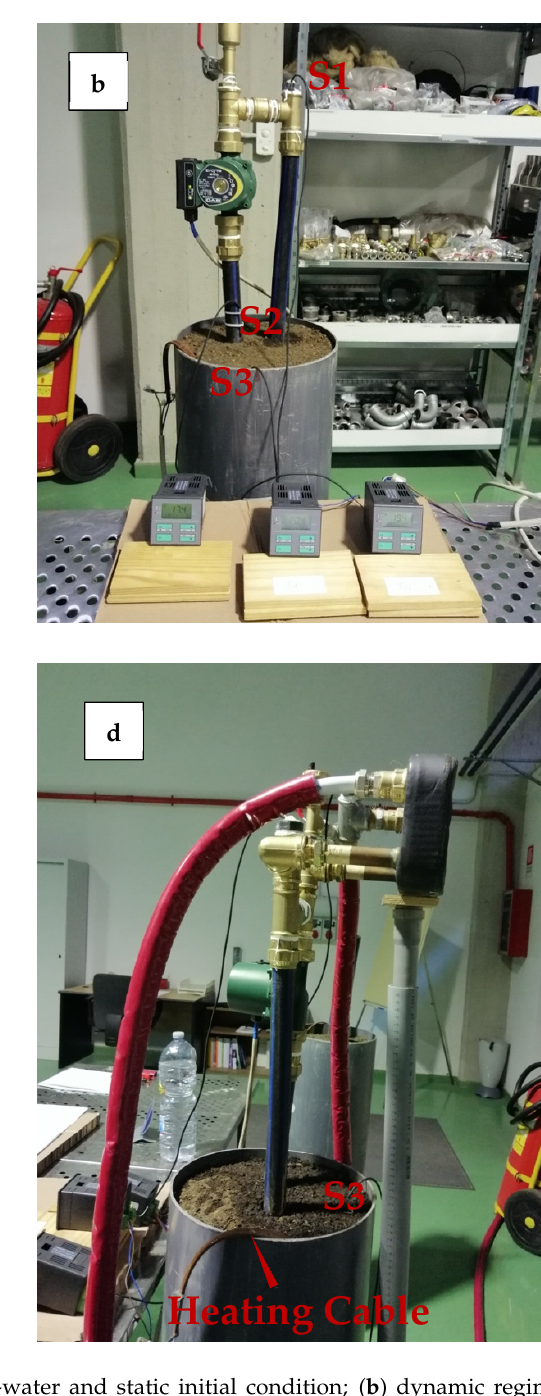
Figure 5. Geo-exchange prototype configuration: ( a ) no-water and static initial condition; ( b ) dynamic regime test; ( c ) primary and secondary circuit configuration; and ( d ) details of the supplementary double circuit device.